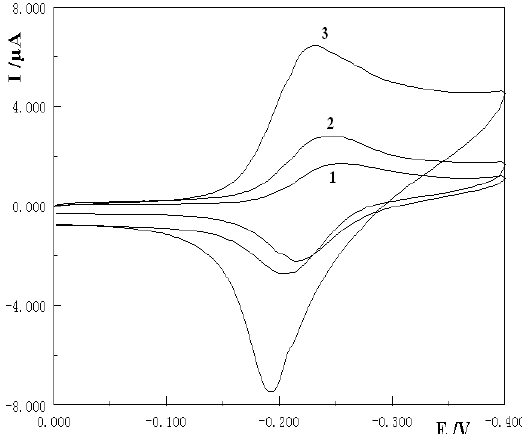
Figure 6. Cyclic voltammograms for the detection of PCR samples by using 1.5×10 -4 mol/L MB at bare gold electrode (1), NOS ssDNA/MAA/Au electrode (2) and the electrode hybridization with PCR amplified real sample